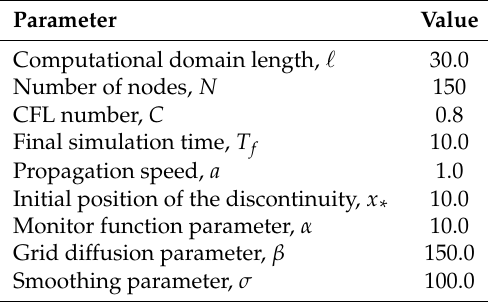
Figure 1. A discontinuous profile propagation under the linear advection of Equation (1): ( a ) A comparison of different profiles (The thin solid line is the exact solution, (1) is the numerical solution on the uniform mesh, (2) is the solution on the moving mesh, and (3) is the first order upwind scheme on the uniform mesh); ( b ) the trajectories of grid nodes in space–time. Note that the Figure 1a shows only a zoom of the computational domain. Table 1. The numerical parameters used to simulate the discontinuous profile propagation under the linear advection of Equation